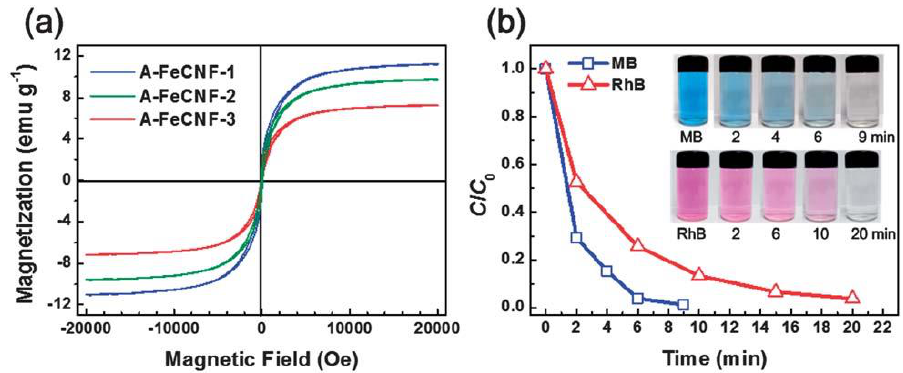
Figure 25. Magnetic hysteresis loops of A-FeCNFs ( a ), dye adsorption over time of A-FeCNFs plotted as the ratio of dye concentration to initial concentration ( b ), and magnetic performance after MB dye adsorption (reproduced from the work in [61] with permission).